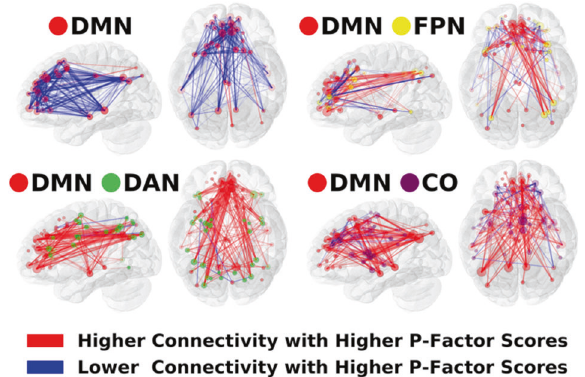
Fig. 3 Default mode network connections associated with the P factor. The results from our network analysis showed that the P factor is associated with hypoconnectivity within DMN and hyperconnectivity between DMN and three control networks, FPN, DAN, and CO. DMN = default mode network, FPN = frontoparietal network, DAN = dorsal attention network, CO = cingulo-opercular network.